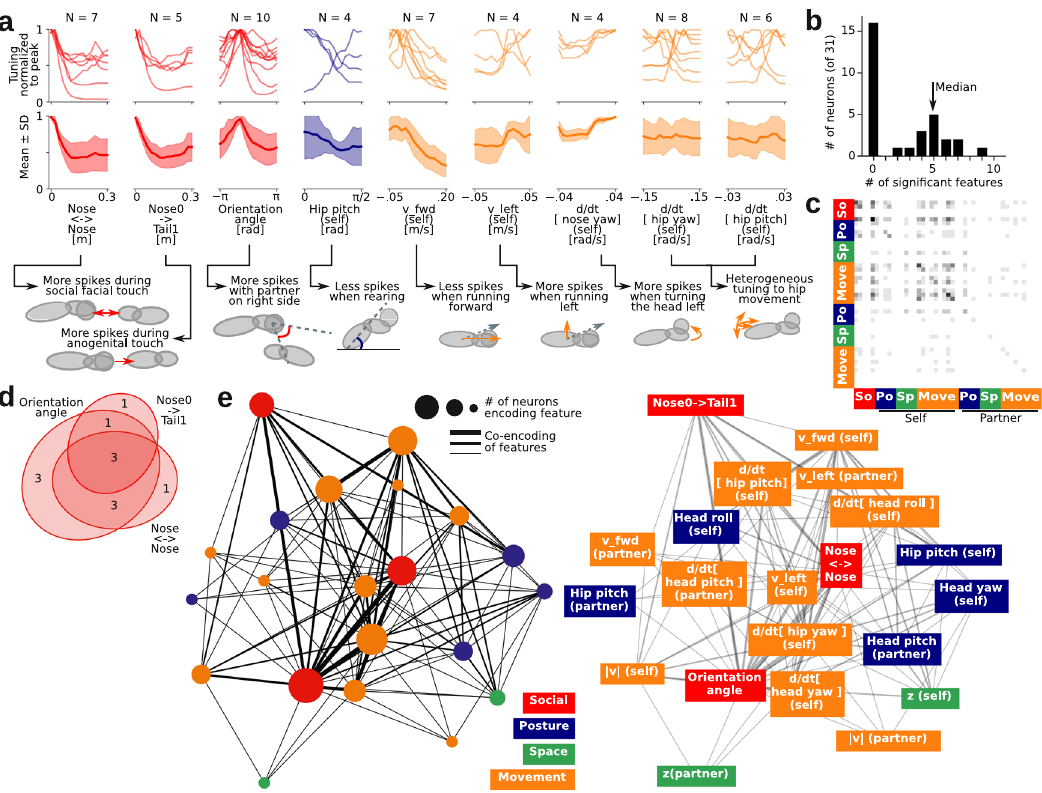
Fig. 8 Population tuning and co-encoding network structure in a social situation. a Top, single neuron tuning curves and ‘ population tuning curve ’ (average tuning, shaded area indicates standard deviation) for all behavioral features encoded by more than three single neurons. Bottom, schematic depiction of the physical interpretation of the population tuning, in relation to the 3D body models. b Distribution of the number of behavioral features that each single neuron multiplexes. The arrow indicated the median number of features encoded by a neuron that encode at least one feature. c Co-encoding matrix of the neural population: The grayscale color in i ’ th and j ’ th bin in the heatmap indicates the number neurons that encode both feature i and j (ordering and color on the axes as in Fig. 7). d Euler diagram of a subset of the co-encoding matrix: This shows the number of neurons that encode nose-to- nose touch, implanted-nose-to-partner-tail touch, and orientation angle (i.e., are lateralized). e Network graph depiction of the full co-encoding matrix. The size of the nodes indicates the number of neurons that encode a feature, the width of the edges indicates the number of neurons that co-encode a behavioral feature. The network is shown in the Kamada – Kawai projection 86 (the distance between nodes approximate their graph-theoretical distance), with additional text labels on the network on the right. Source data and analysis scripts that generate the fi gures are available in the associated code/data fi les (see “ Methods ”